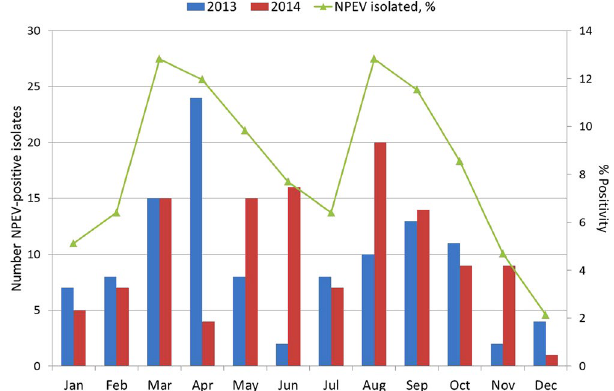
Figure 1. Monthly distribution of NPEV isolates from AFP cases, West Africa,